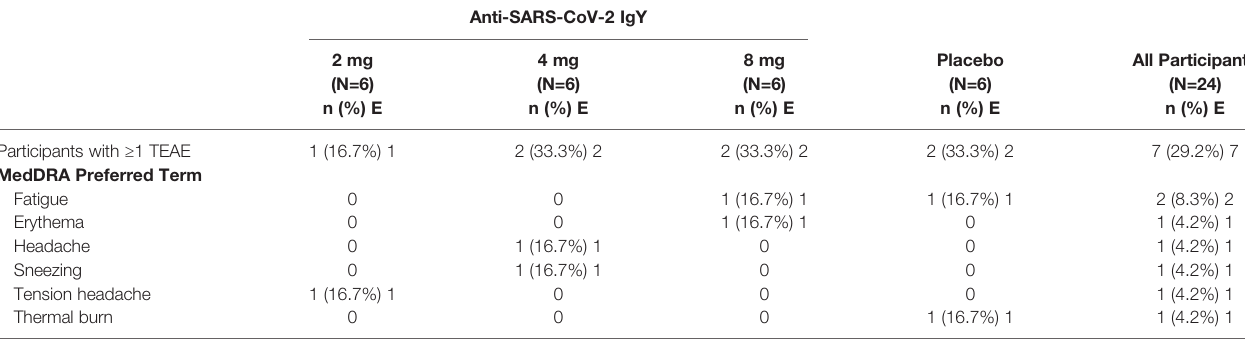
TABLE 3 | Adverse events by preferred term- single ascending-dose study (Part 1).